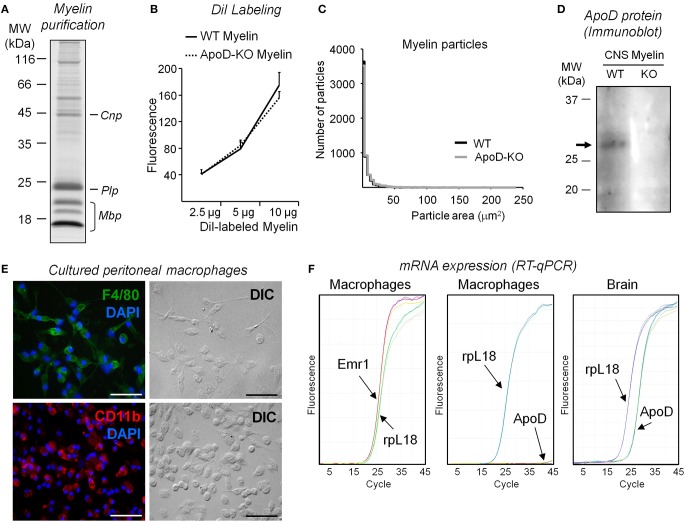
Characterization and quality controls of myelin extracts and peritoneal macrophage cultures. (A) SDS-PAGE separation of myelin isolated from brains of WT mice stained with Coomassie blue. (B) DiI labeling of myelin assayed by fluorimetry measurements (excitation λ = 545 nm, emission λ = 568 nm). No differences in DiI incorporation are observed in myelin from each mouse genotype. A representative pair of myelin preparations is shown. (C) Size distribution of myelin particles in two independent myelin preparations (ten 10× fields/experiment). (D) Immunoblot analysis of ApoD in myelin preparations isolated from brains of WT and ApoD-KO mice. The arrow points to the ApoD band. (E) Characterization of peritoneal macrophage cultures. The cultured cells express F4-80 and CR3/Cd11b markers, as evidenced by immunofluorescence. Calibration bars: 50 μm. (F) ApoD mRNA was not detected by RT-qPCR in peritoneal macrophages, while the macrophage gene Emr1/F4-80 is amplified. Brain mRNA was used to amplify ApoD as a positive control in the same RT-qPCR.